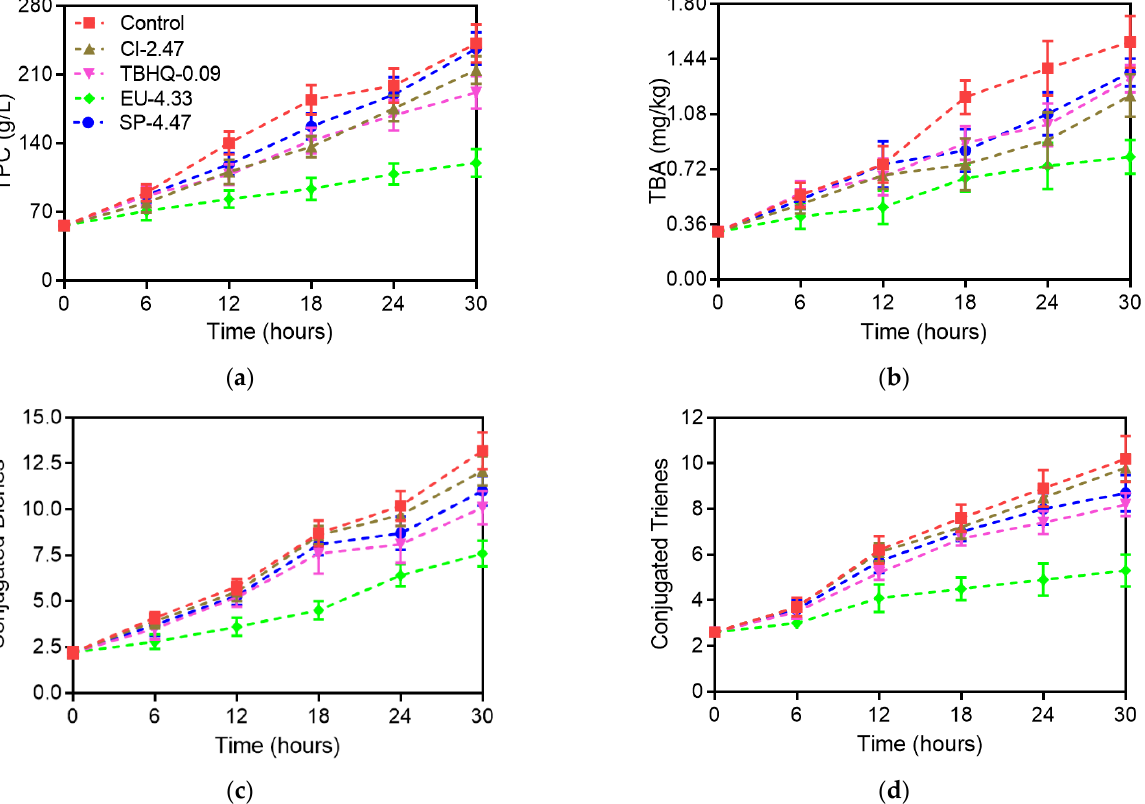
Figure 4. The values for the total polar compounds (TPC, ( a )), thiobarbituric acid (TBA, ( b )), conjugated dienes ( c ) and conjugated trienes ( d ) of sunflower oil added by nothing, 1,8-cineole (2.47 mg/kg, CL-2.47), TBHQ (0.12 g/kg, TBHQ-0.09), eugenol (4.33 mg/kg, EU-4.33), and spathulenol (4.47 mg/kg, SP-4.47) during the deep-frying of youtiao for 30 h. Values are expressed as mean ± SD (n = 10).